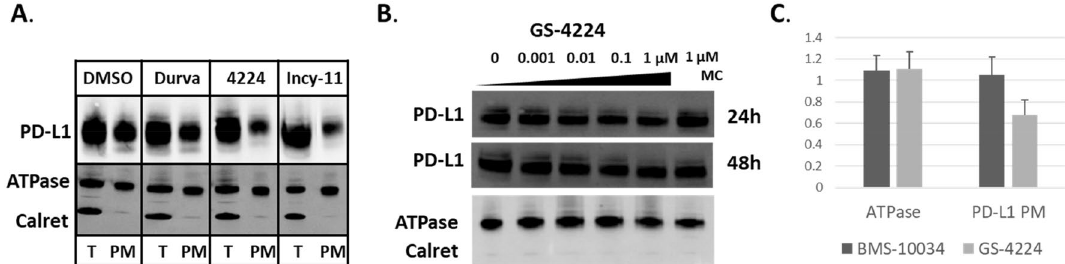
Figure 3. WB analysis of reduction in PD-L1 on the cell surface. ( A ) PD-L1 levels in plasma membrane isolated from MDA-MB231 GFP. WB signal from samples treated with durvalumab, GS-4224, or INCY-11 is compared to the one obtained for the DMSO control. Na + /K + ATPase is used as the plasma membrane marker, and calreticulin as the ER marker. T stands for total protein fraction, PM stands for plasma membrane fraction. ( B ) Titration of GS-4224 compound in MDA-MB-231 GFP cells. Tenfold serial dilution was used with a concentration range: 1 nM–1 µM and with samples collected at 24 h and 48 h. Annotation is as in ( A ), and MC stands for macrocycle, BMS-10034. ( C ) Bar graph comparison of WB signal intensity for PD-L1 plasma membrane protein in MDA-MB-231 GFP cells treated with either 1 µM GS-4224 or 1 µM BMS-10034. Na + /K + ATPase is used as a control for general plasma membrane protein levels. Cropped and grouped blots here and in all the following figures are explicitly delineated either with dividing lines or white space. All uncropped blots are included in the Supplemental